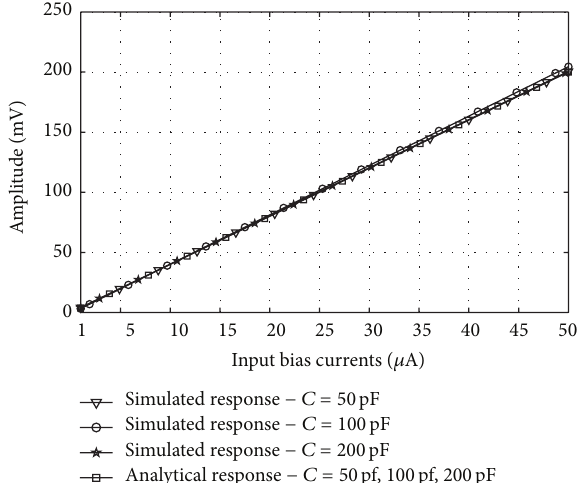
Figure 15: Amplitude versus bias current of pulse generator.